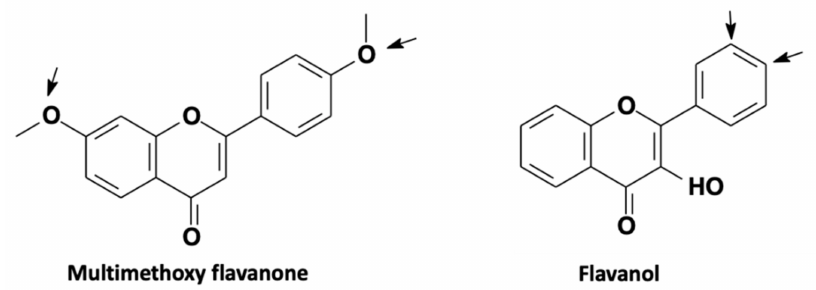
Figure 3. Demethylation sites of multimethoxylated flavanones and methylation sites of flavanols that can be modified by microbial enzymes during fermentation. The arrows indicate the demethylation and methylation sites of each compound